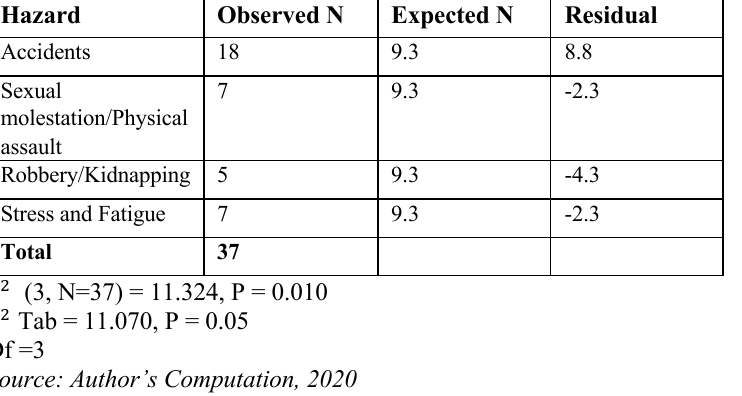
Table 5b. Statistical Analysis of hawking